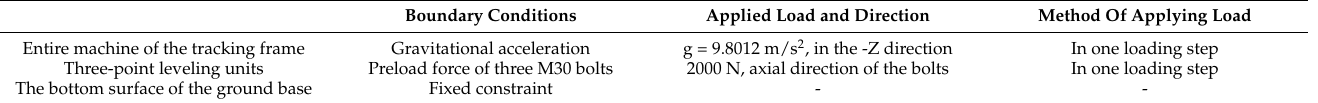
Table 5. Boundary conditions of parameterized model.